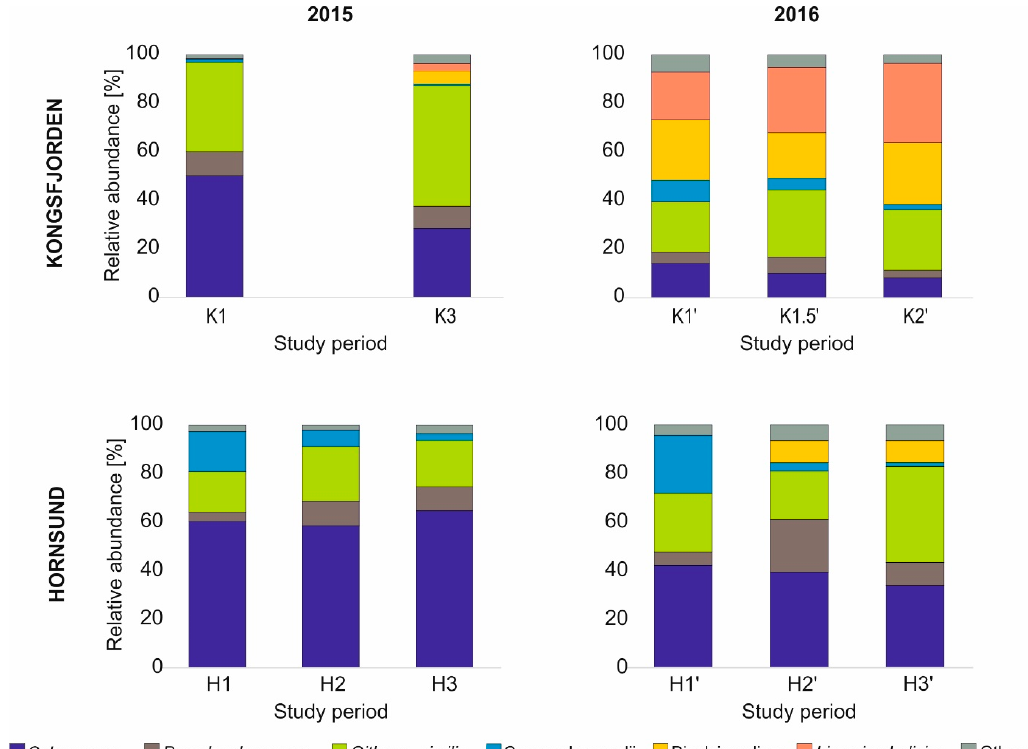
Figure 5. Zooplankton community structure in Kongsfjorden and Hornsund.